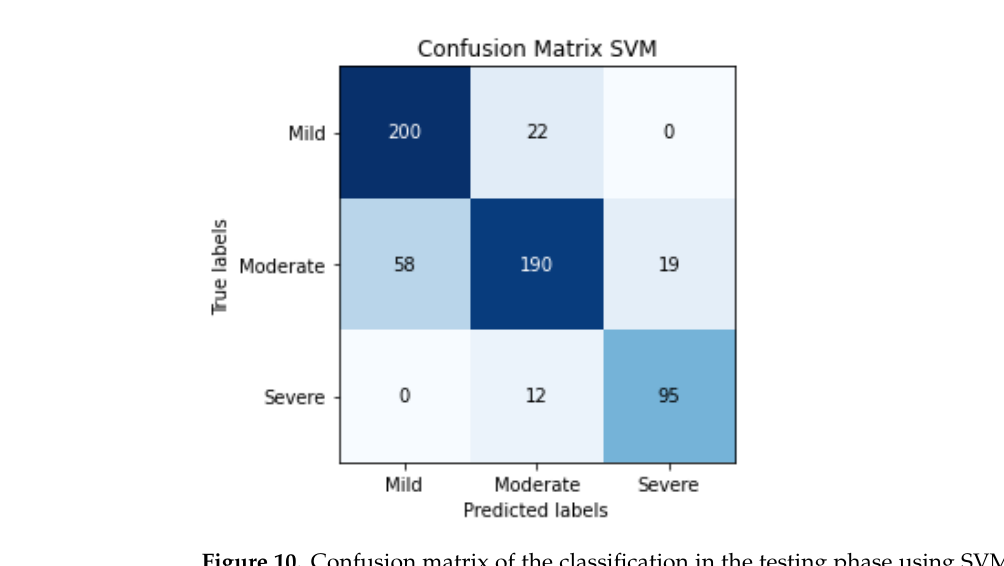
Figure 10. Confusion matrix of the classification in the testing phase using SVM for detecting the severity degree of the lungs of a patient (summary of 5 folds evaluated in testing phase). Table 4. Results of the classification in the testing phase using SVM for detecting the severity degree of the lungs of a patient (summary of 5 folds evaluated in the testing